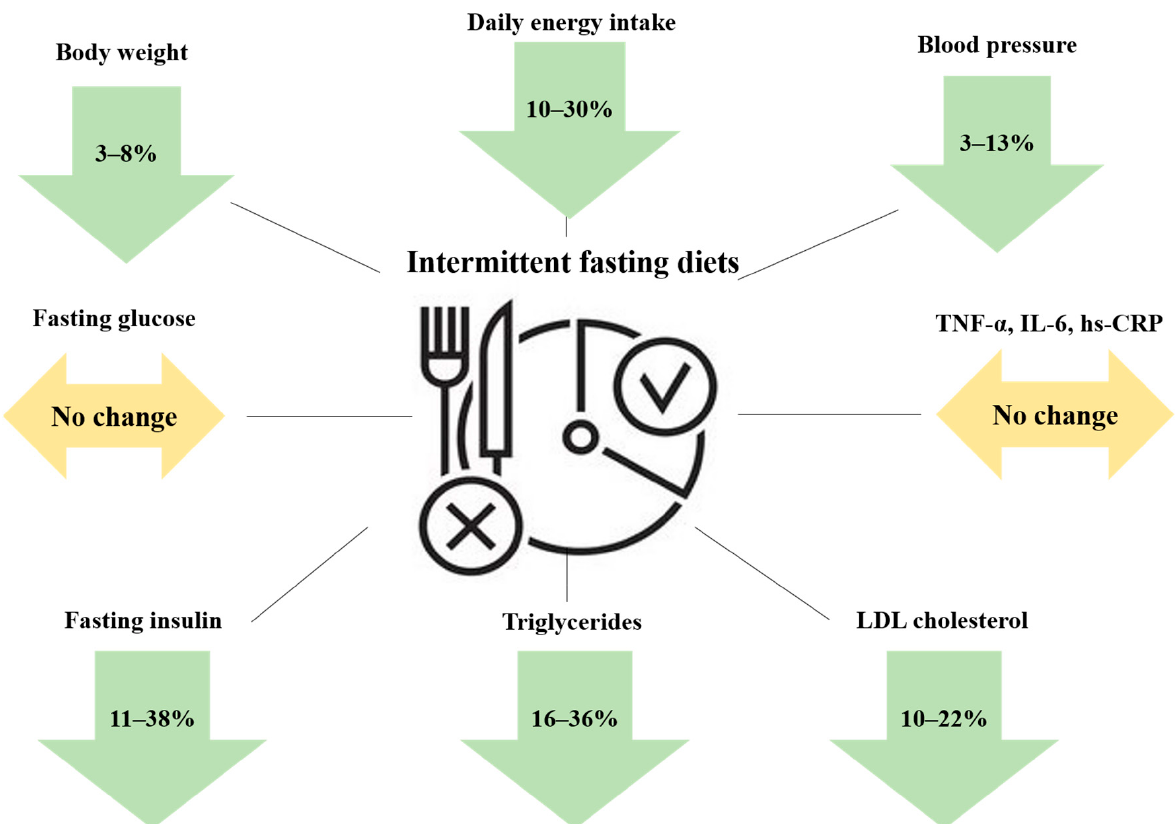
Figure 1. A graphical summary of the major effects of intermittent-fasting diets on body weight and cardiometabolic risk factors. Abbreviations: hs-CRP: high-sensitivity C-reactive protein; IL-6: interleukin-6; LDL: low-density lipoprotein; TNF- α : tumor necrosis factor α . The downward arrows indicate a decrease, while the horizontal arrows indicate lack of change in the respective parameters.